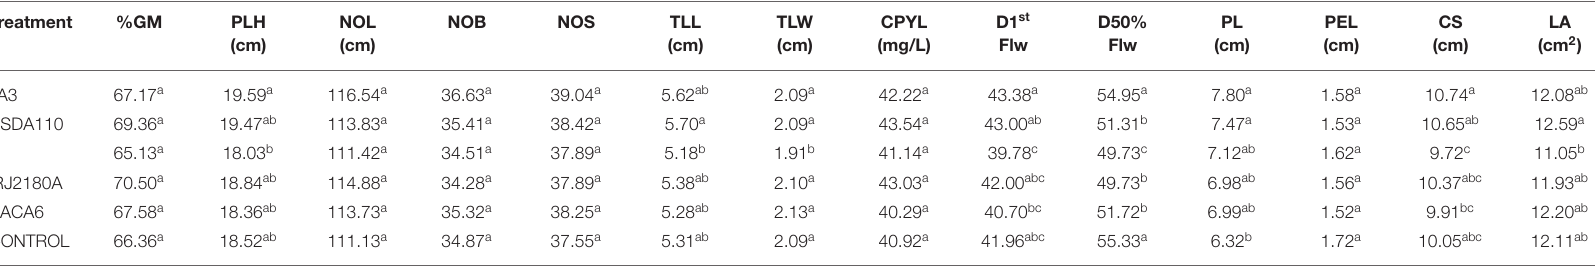
TABLE 6 | Effect of N fertilizer and B. japonicum strains on the percentage of germination at 2 WAP, growth traits of accessions of Bambara groundnut at 7 WAP, and flowering in Ibadan and Ikenne during both seasons. Treatment